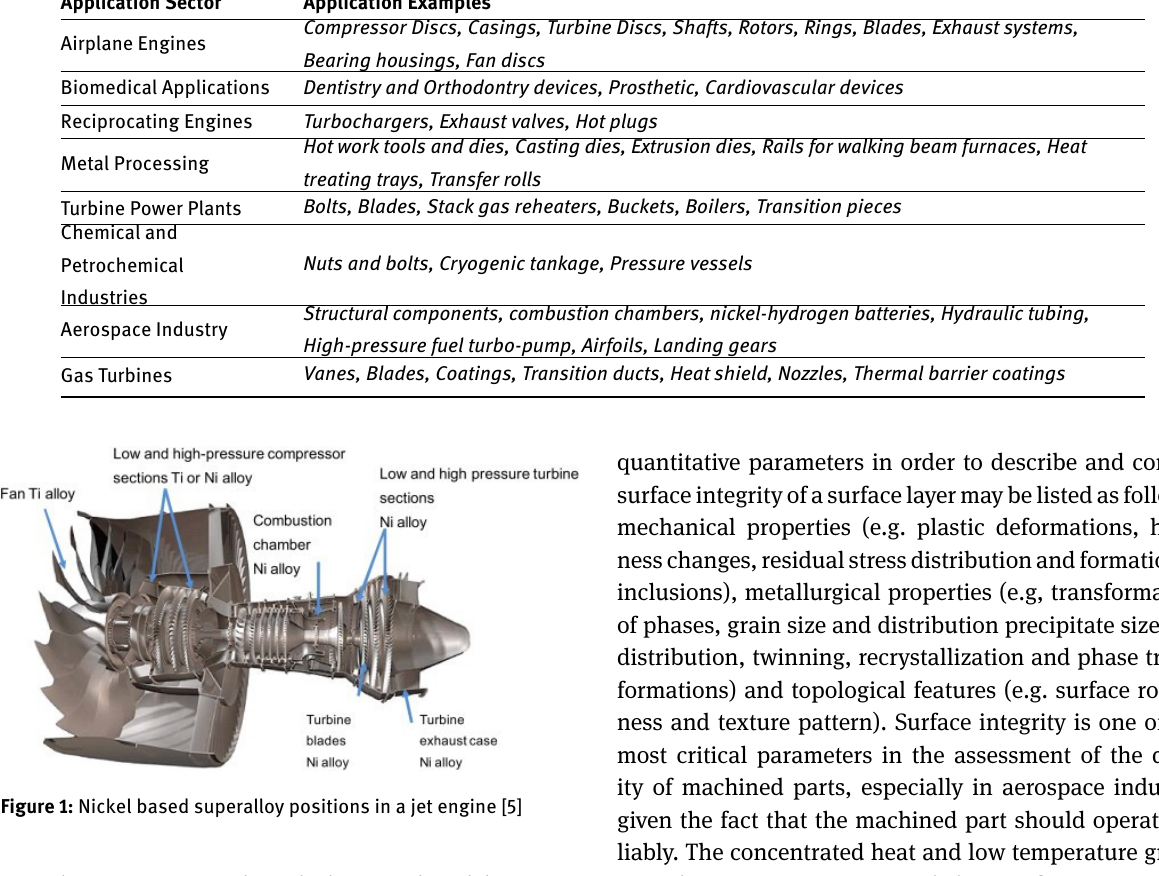
ity is the continuous and tough chips produced during ma- chining. Although there are significant improvements in cutting tools, machine control systems, cooling and lubri- cation technology, machining of superalloys is still lead- ing to problems in terms of cutting tool wear and surface